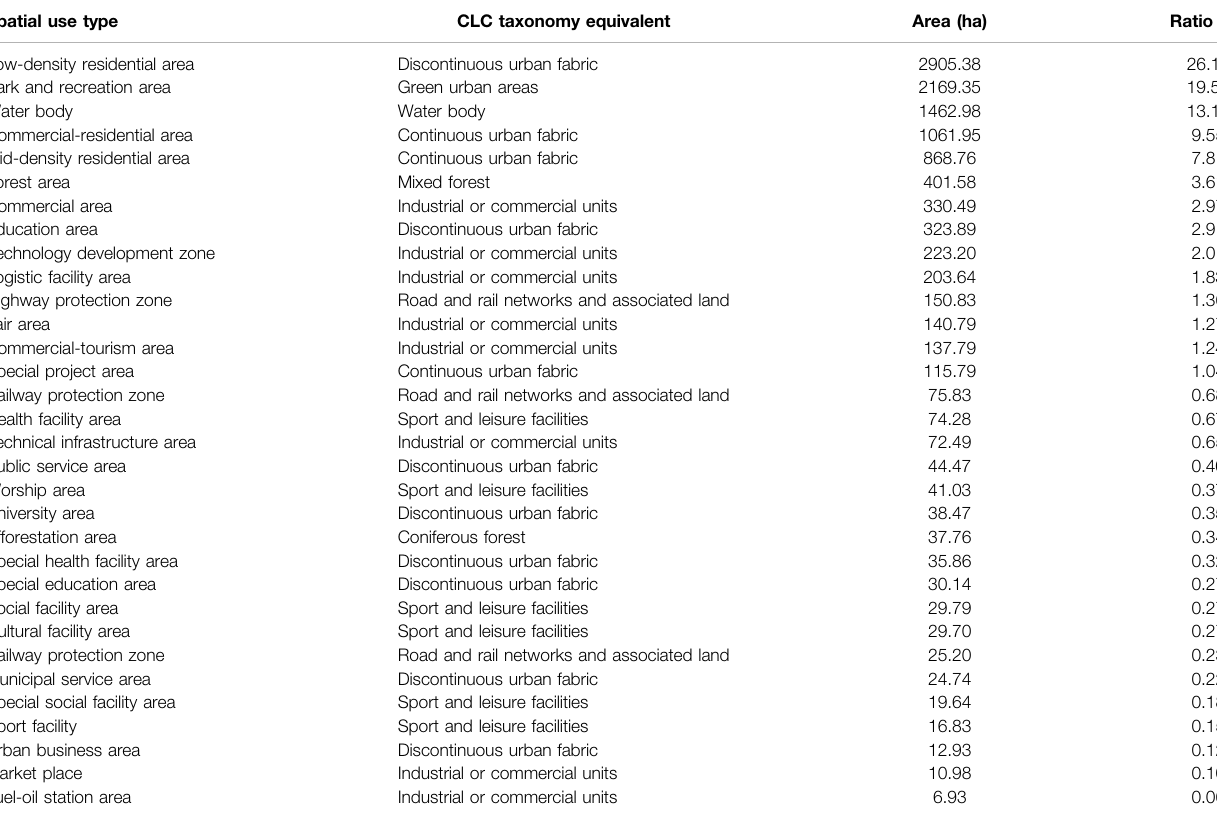
TABLE 5 | Spatial use types as given in Canal Istanbul ’ s spatial